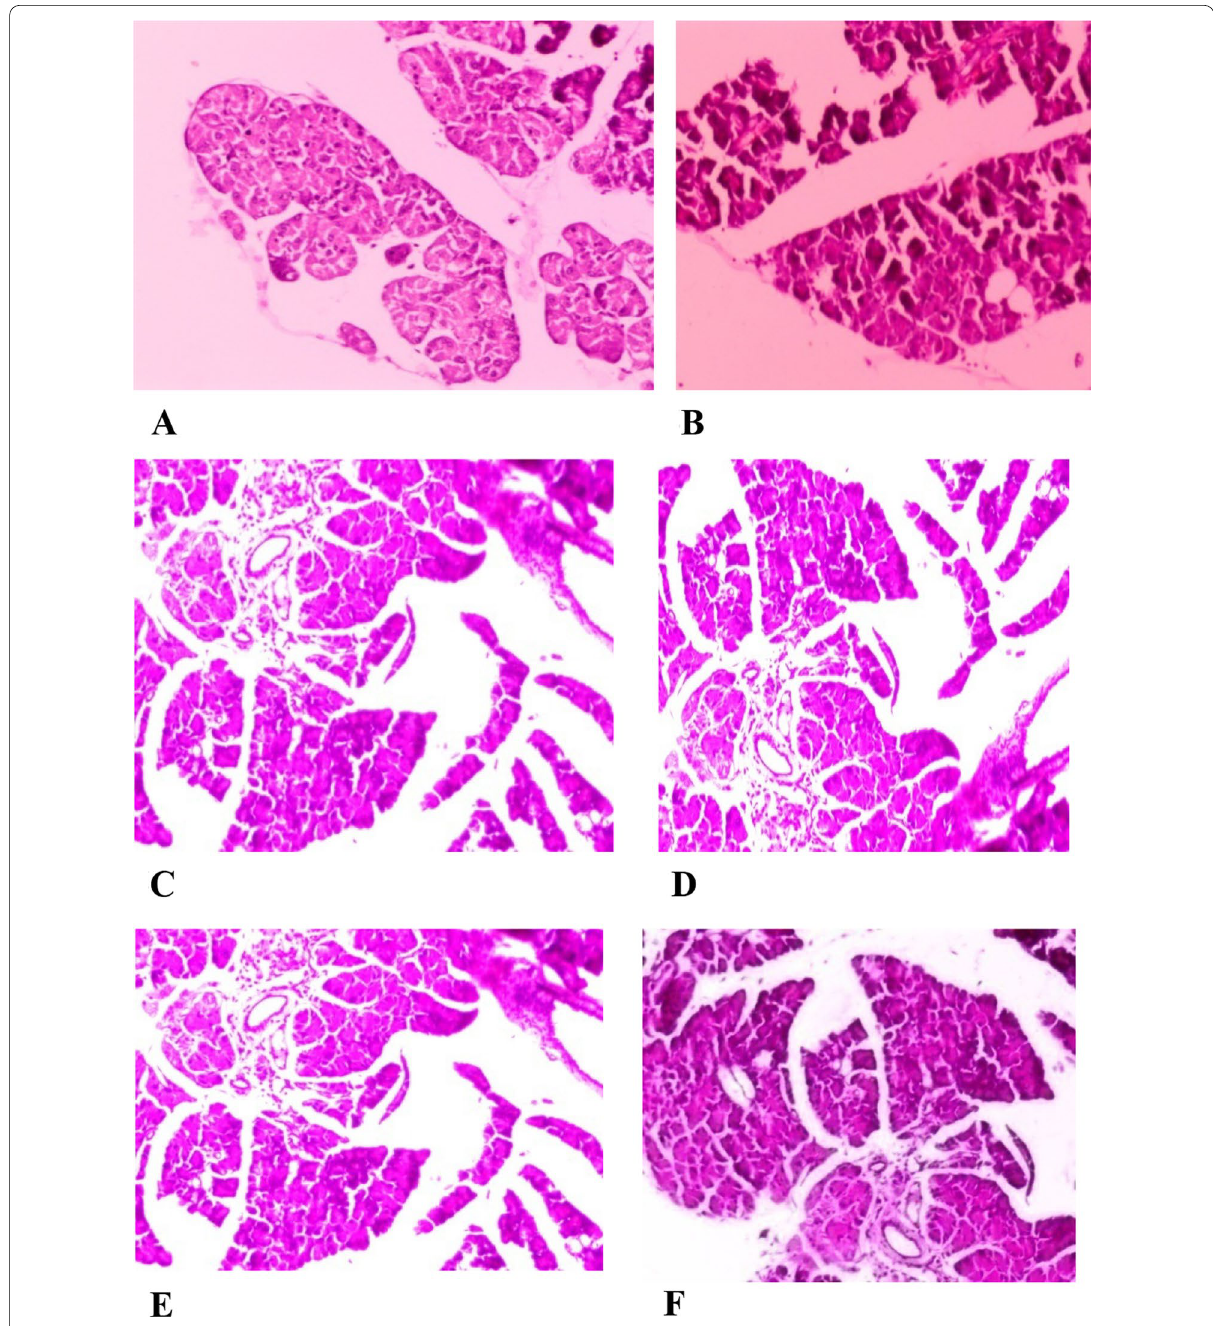
Fig. 15 Hematoxylin and eosin-stained sections of mice pancreas. a Islets of Langerhans of normal control mice. b Destruction of islets of Langerhans in diabetic mice ( c – e ). Remnants of islets of Langerhans diabetic mice treated with c 100 mg/kg and d 200 mg/kg e 300 mg/kg per day MELCF which reduced the development of STZ-induced alterations in the liver. f Islets of Langerhans of metformin 200 mg/kg treated